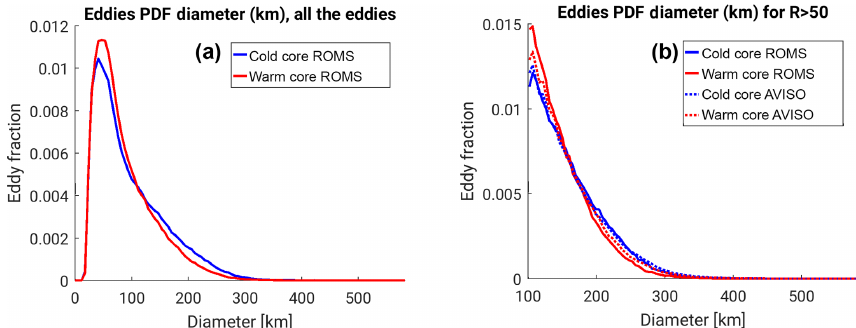
Figure B3. Distribution of the eddy diameters [km] in the CanUS region as defined by the budget analysis boxes: (a) probability density function (PDF) of the diameter of all the eddies from ROMS; (b) comparison of the PDFs limited to large eddies ( R > 50km) for the eddies from ROMS and